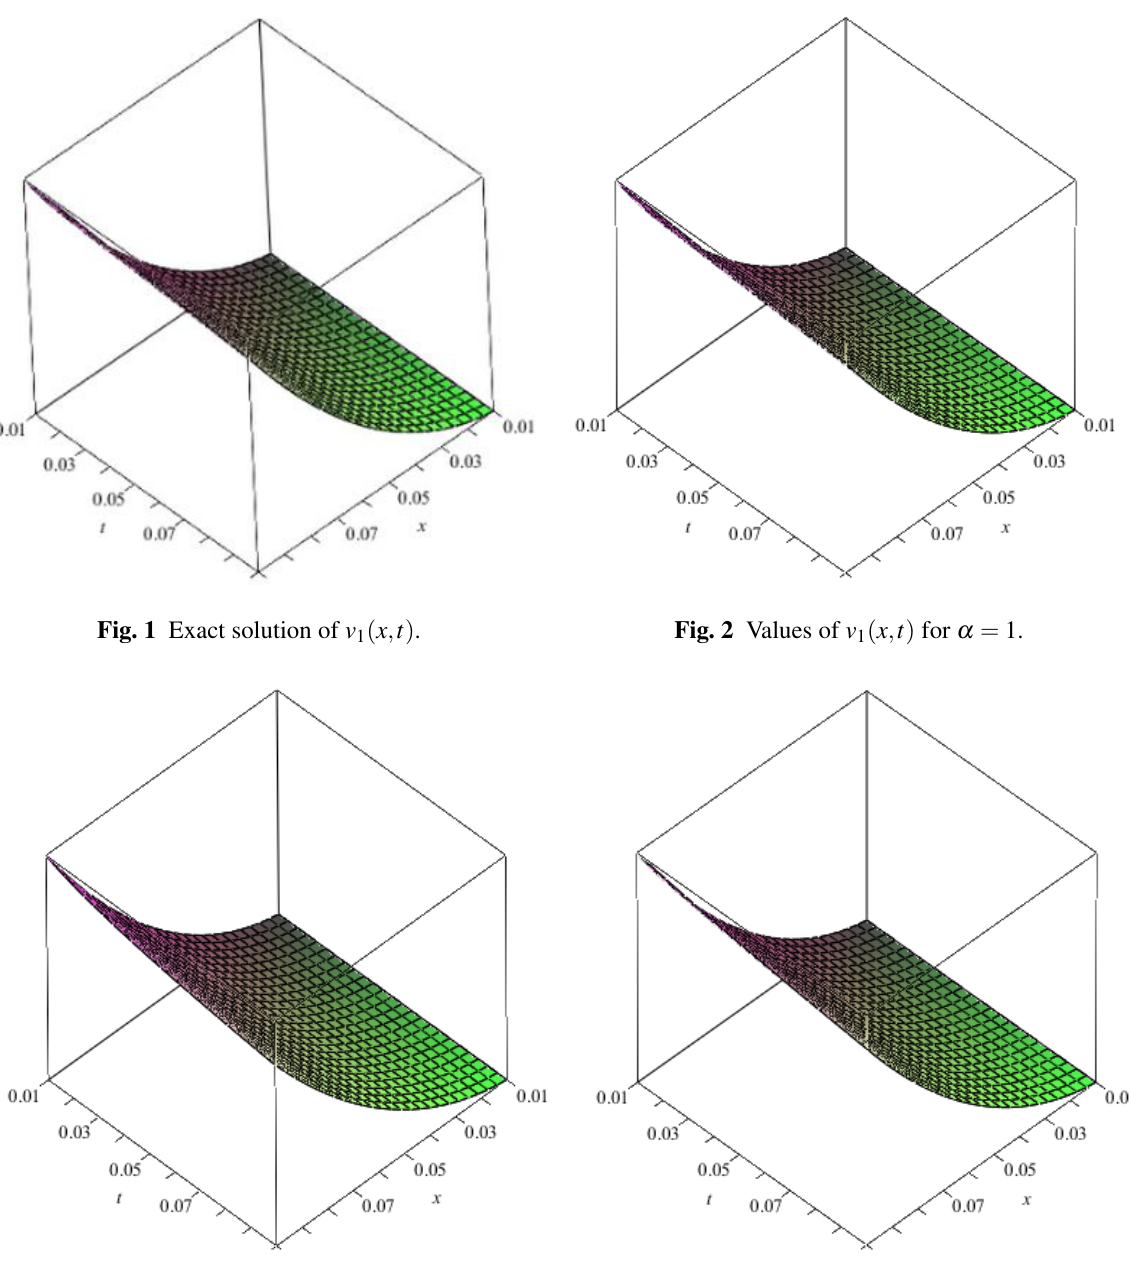
Fig. 3 Values of v 1 ( x , t ) for α = 0 . 5. Fig. 4 Values of v 1 ( x , t ) for α = 0 .